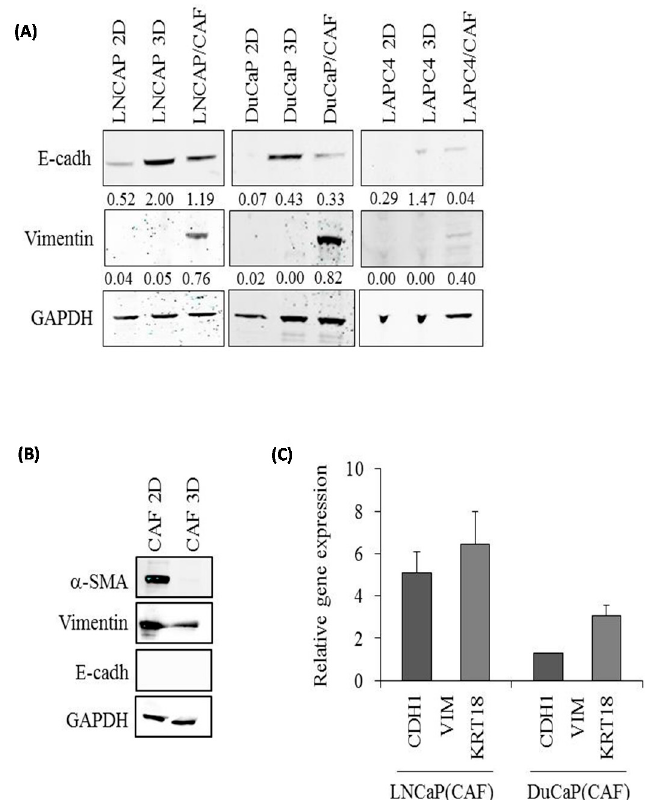
Figure 4. E-cadherin and vimentin protein expression in 3D spheroids compared to 2D monolayers. Expression of ( A ) E-cadherin (E-cadh) and vimentin and ( B ) α -smooth muscle actin ( α -SMA), vimentin (VIM), and E-cadherin (E-cadh) was determined after eight days of culture as mono or co-culture spheroids or 2D monolayer by Western blotting. Representative blots are shown. Values denote mean densitometric intensity relative to glyceraldehyde phosphate dehydrogenase (GAPDH) from at least three independent experiments; ( C ) qPCR for E-cadherin (CDH1), vimentin (VIM) and cytokeratin 18 (KER18) in LNCaP and DuCaP cells after isolation from PCa/CAF co-culture spheroids via FACS. Values denote mean gene expression normalized against GAPDH and HMBS.